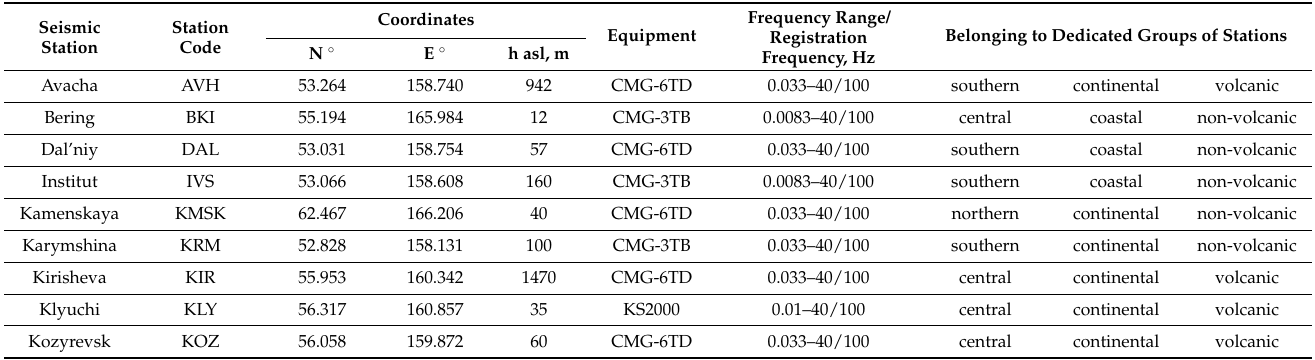
Figure 1. Map of the Kamchatka Peninsula showing the location of seismic stations (Table 1), earthquake epicenters with M w = 7.2–8.3, and tectonic plate boundaries: 1—seismic stations with codes indicated: blue designates coastal stations, and white designates continental stations; 2—earthquake epicenters; 3—areas of earthquake sources according to [20–24]; 4—boundaries of the northern, central, and southern groups of stations (from top to bottom); 5—northwestern and northeastern boundaries of the considered area of the Pacific Oceanic Plate (PA); 6—boundary of the North American continental plate (NA) with PA and small lithospheric plates Beringia (BE) and Okhotsk (OK) [25,26]. White arrows indicate the direction of PA movement; numbers—the speed of TO movement [27]. Table 1. Seismic stations, their equipment [28], and the belonging of stations to selected groups.